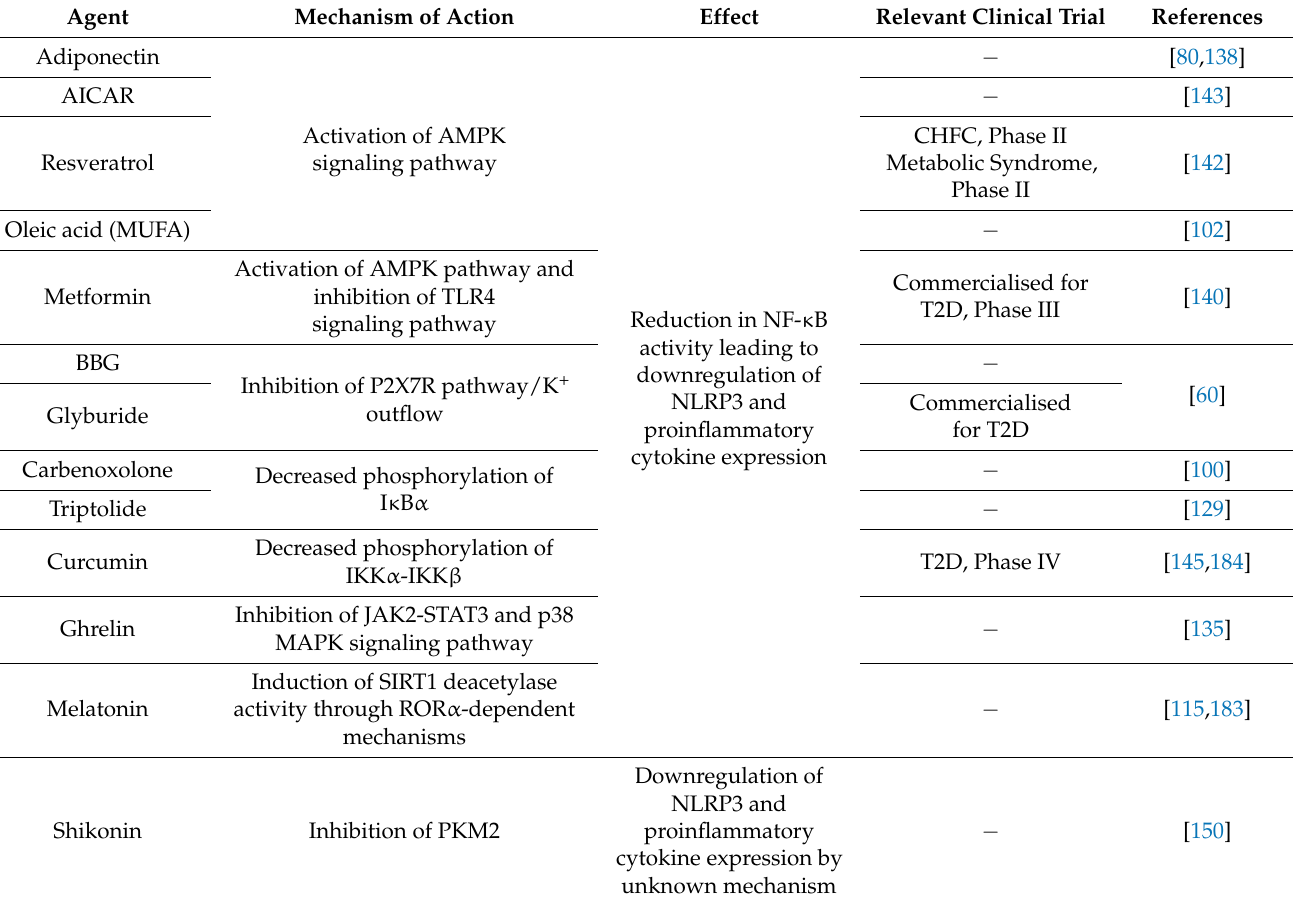
Table 2. List of indirect inhibitors acting upstream of NLRP3 priming in skeletal